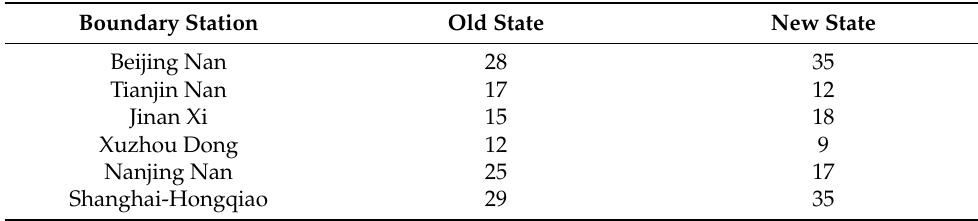
Table 8. The train-set